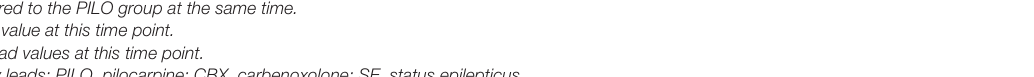
TABLE 2 | Dynamic changes in the average and peak spectral power of FRs recorded in RLs in the PILO and CBX + PILO groups at different time points after SE ( n = 8). Time points Average spectral power of FRs Peak spectral power of FRs PILO CBX +